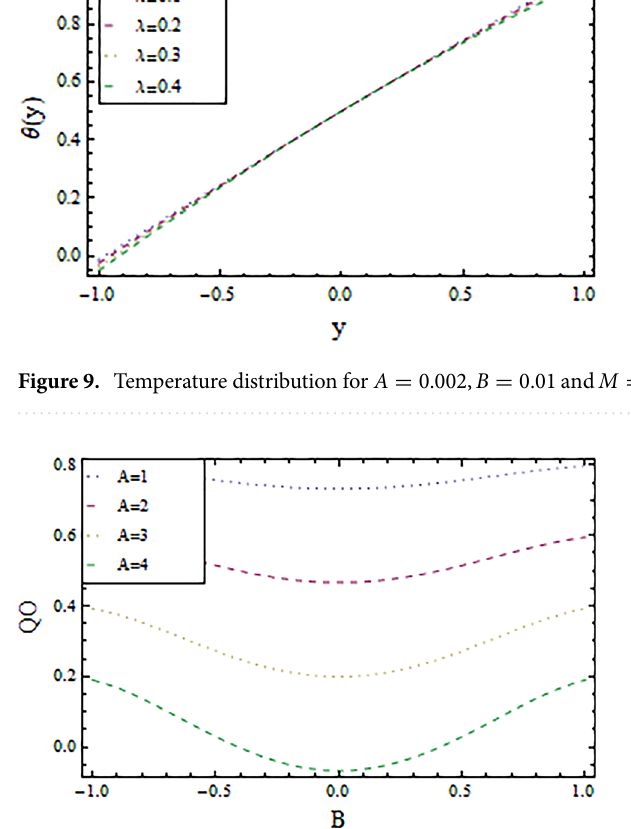
Figure 10. Volume flux of generalized plane Couette flow for M = 0.0005, (cid:31) = 1 using OHAM.